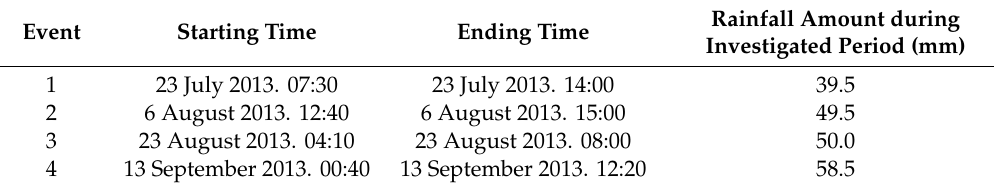
Table 8. Characteristics of observed rainfall event data (Dorim Stream).